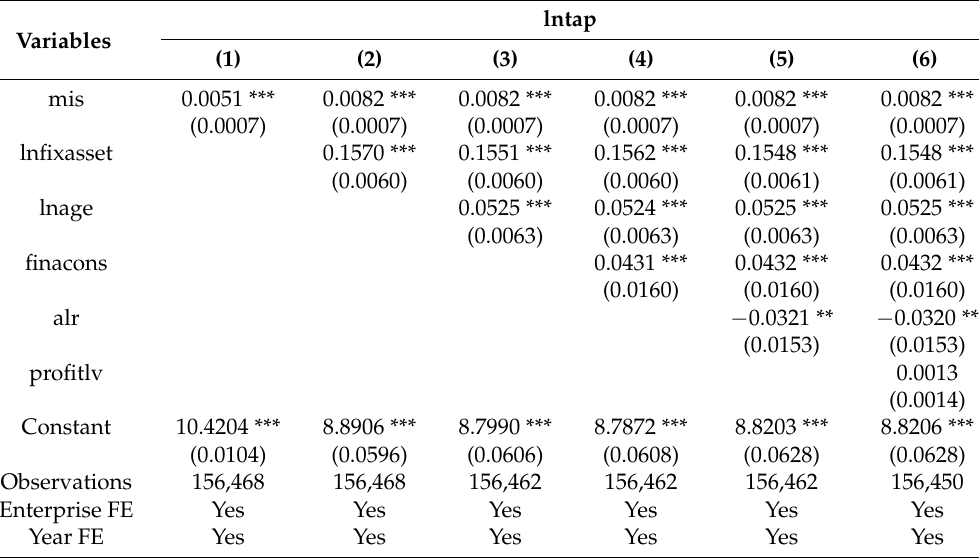
Table 2. Empirical results of Hypothesis 1.